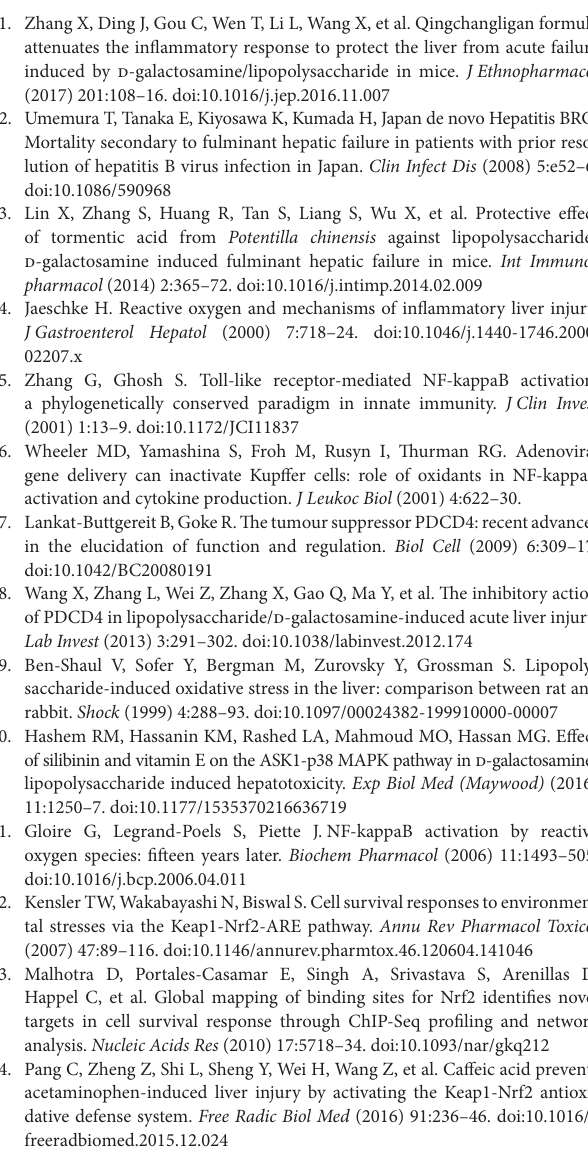
FigUre s2 | Effects of asiatic acid (AA) exposure on activation of the AMP-activated protein kinase (AMPK)/GSK3 β /Nrf2 signaling pathways in HepG2 cells. (a) HepG2 cells were treated with AA (6 µM) for 1, 3, or 6 h. Western blotting analysis were used to explore phosphorylated AMPK and GSK3 β expression as well as Nrf2 protein expression. (e) HepG2 cells were treated with compound C (CC, an AMPK inhibitor, 3 µM) for 18 h and then incubated with AA (6 µM) for another 6 h. (B–D,F–h) Quantification of relative protein expression was performed by densitometric analysis. β -actin was acted as an internal control. Similar results were obtained from three independent experiments. All data are presented as means ± SEM ( n = 5 in each group). * p < 0.05 and **p < 0.01 vs. control